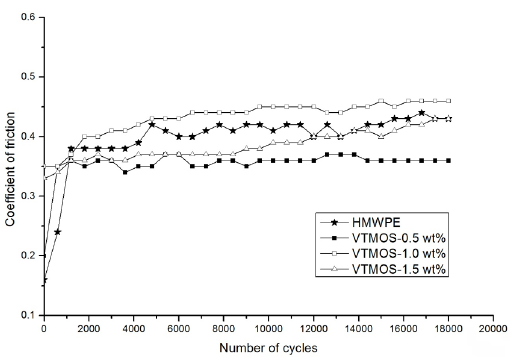
Figure 4. Relationship between the coefficient of friction of the HMWPE/Carbon Steel 1020 and VTMOS crosslinked polyethylenes/ Carbon Steel 1020 friction pairs and the slip cycles.